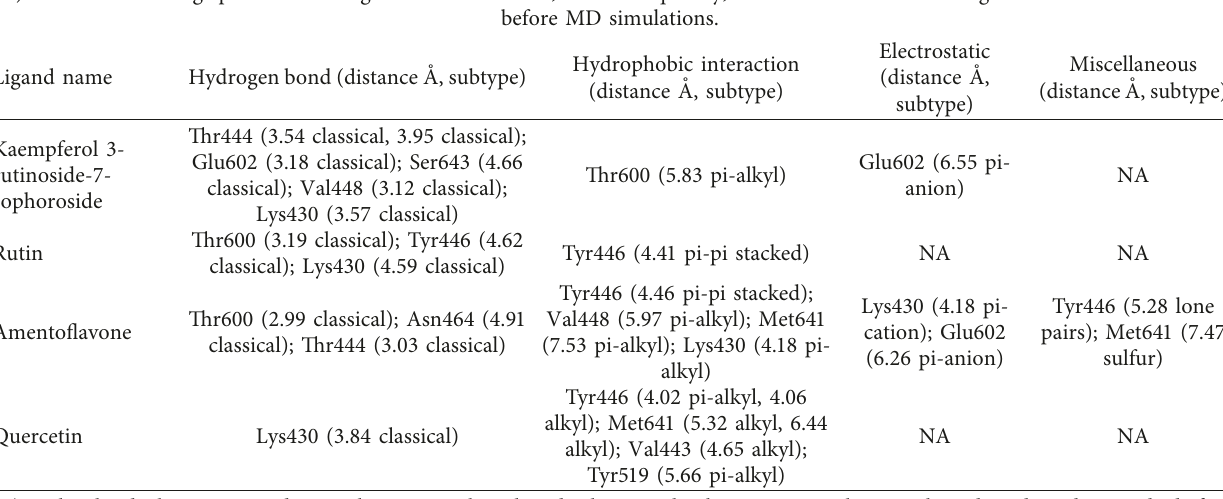
Table 2: Interaction modes between top-ranked SauPBP2a inhibitors and active site of the enzyme. (A) Molecular dockings performed using the AutoDock tool, and subsequently, the interactions between ligands and residues studied before MD